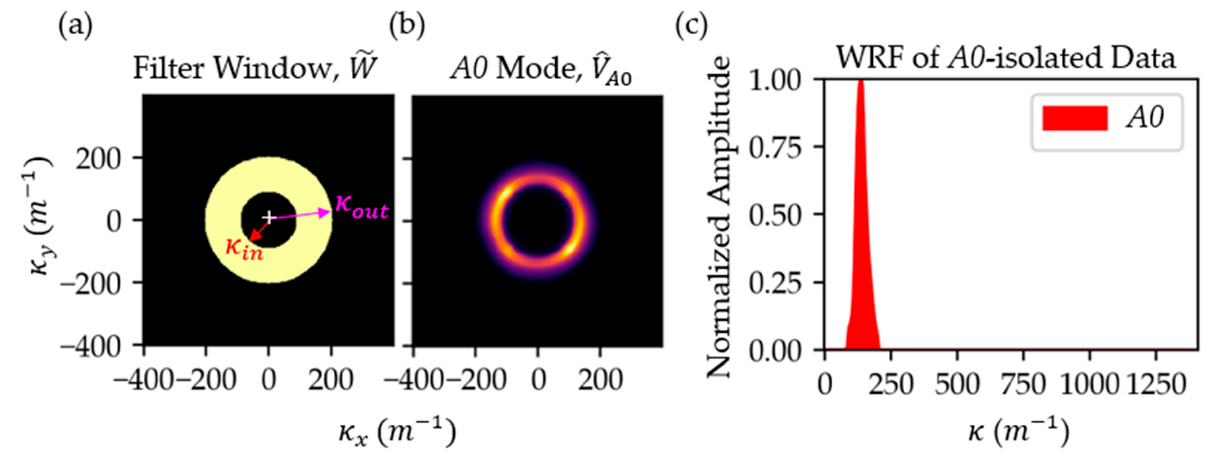
Figure 4. Effect of mode filtering. ( a ) Filter window for A0 mode. ( b ) TCWS and ( c ) WRF after the Figure 4. E ff ect of mode fi ltering. ( a ) Filter window for A0 mode. ( b ) TCWS and ( c ) WRF after the isolation of A0 isolation of A0 mode.